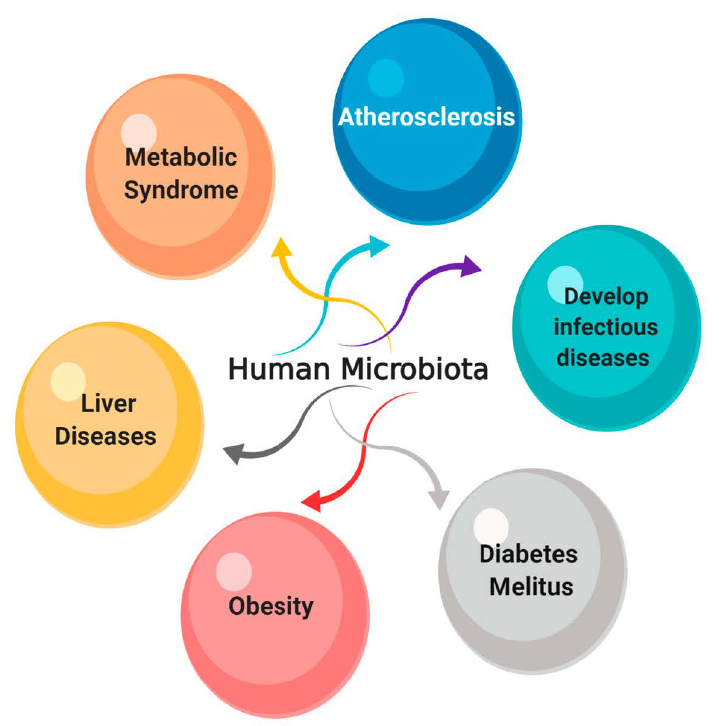
Figure 8. Relationship of microbiota disturbance with developing diseases in different